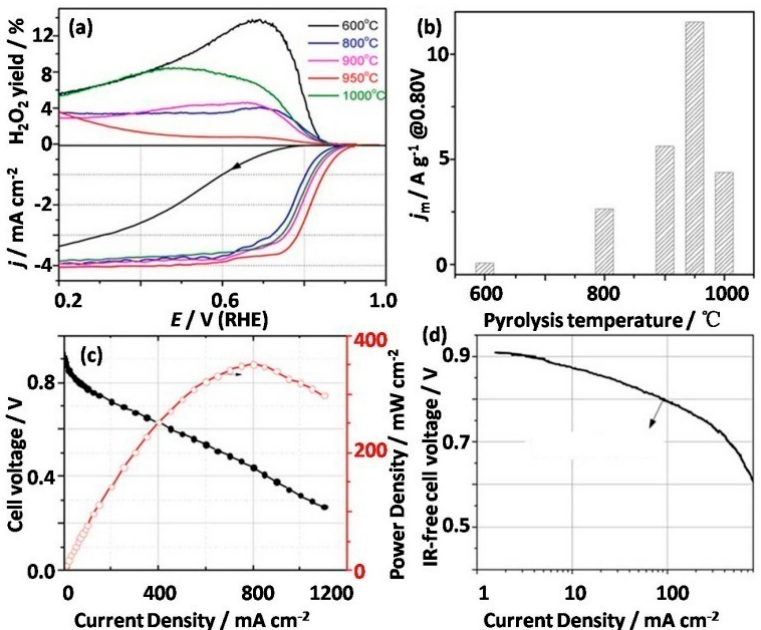
Figure 3. ( a ) ORR polarization curves and H 2 O 2 yield plots of PmPDA–Fe–N x /C catalyst prepared at different pyrolysis temperature, measured in O 2 -saturated 0.1 M H 2 SO 4 . Catalyst loading: 0.6 mg cm − 2 ; Scan rate: 10 mV s − 1 ; and Rotating speed: 900 rpm. ( b ) Variety of ORR mass activity at 0.80 V with pyrolysis temperature. ( c ) Polarization and power density plots for H 2 O 2 single fuel cell with PmPDA–Fe–N x /C as cathode catalyst at 80 °C. MEA active area: 2.0 cm 2 ; Nafion 211 membrane; cathode catalyst loading: 4 mg cm − 2 ; Anode catalyst: Pt/C (60 wt. %, JM) with Pt loading of 0.5 mg cm − 2 . No back pressure was applied. ( d ) Plot of iR -free cell voltage versus the logarithm